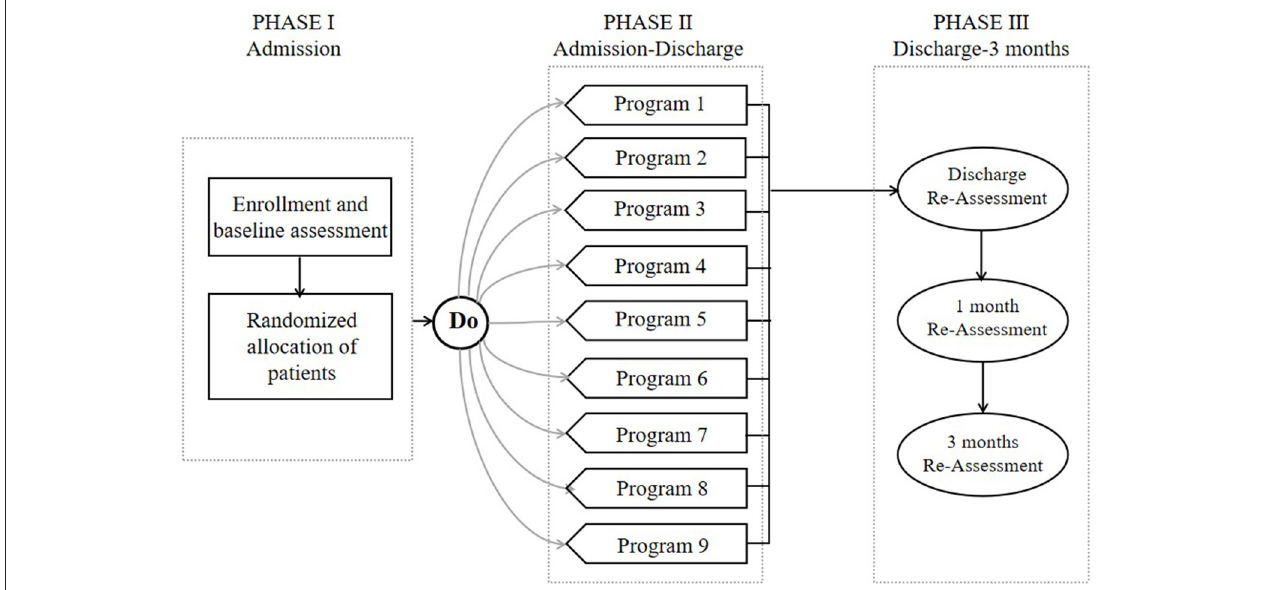
FIGURE 2 | Study design showing the three phases and four assessments.